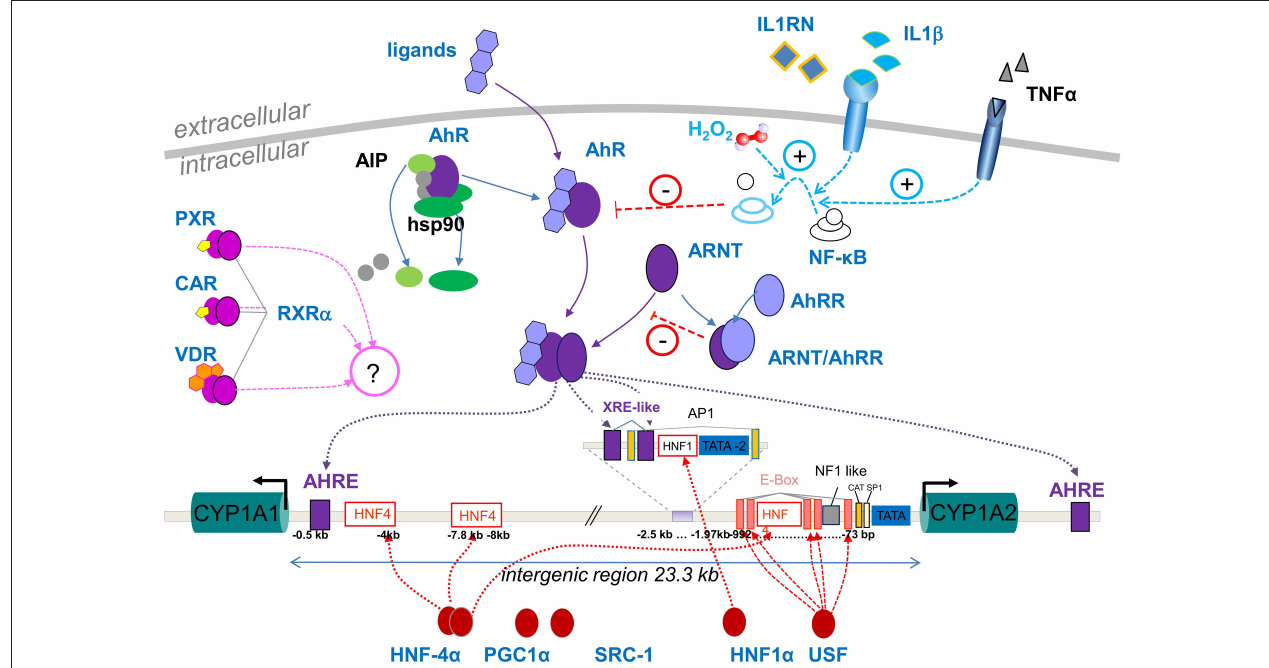
correctly fold and stabilize the AhR and prevent inappropriate trafficking to the nucleus (Petrulis et al., 2000). Upon heterodimerization with activated AhR, the ARNT/AhR complex translocates to the nucleus to activate transcription from AHRE- and XRE-motifs (Okino et al., 2007). AhRR competes with AhR for